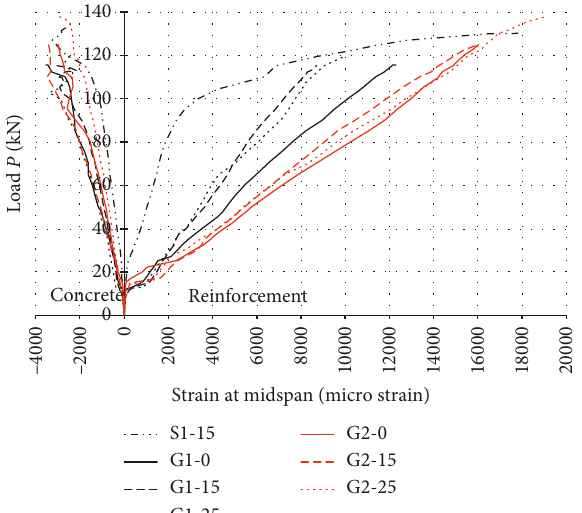
Figure 11: Load-strain relationship at the midspan for tested beams.